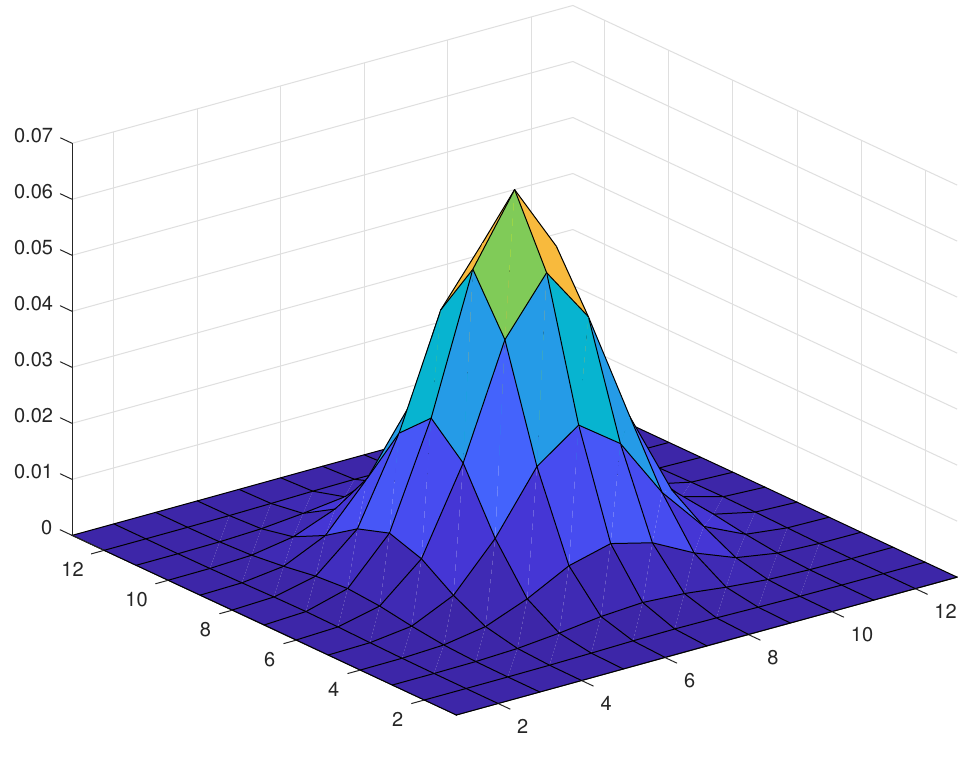
Figure 1. A weight for δ = 0.015 and η =